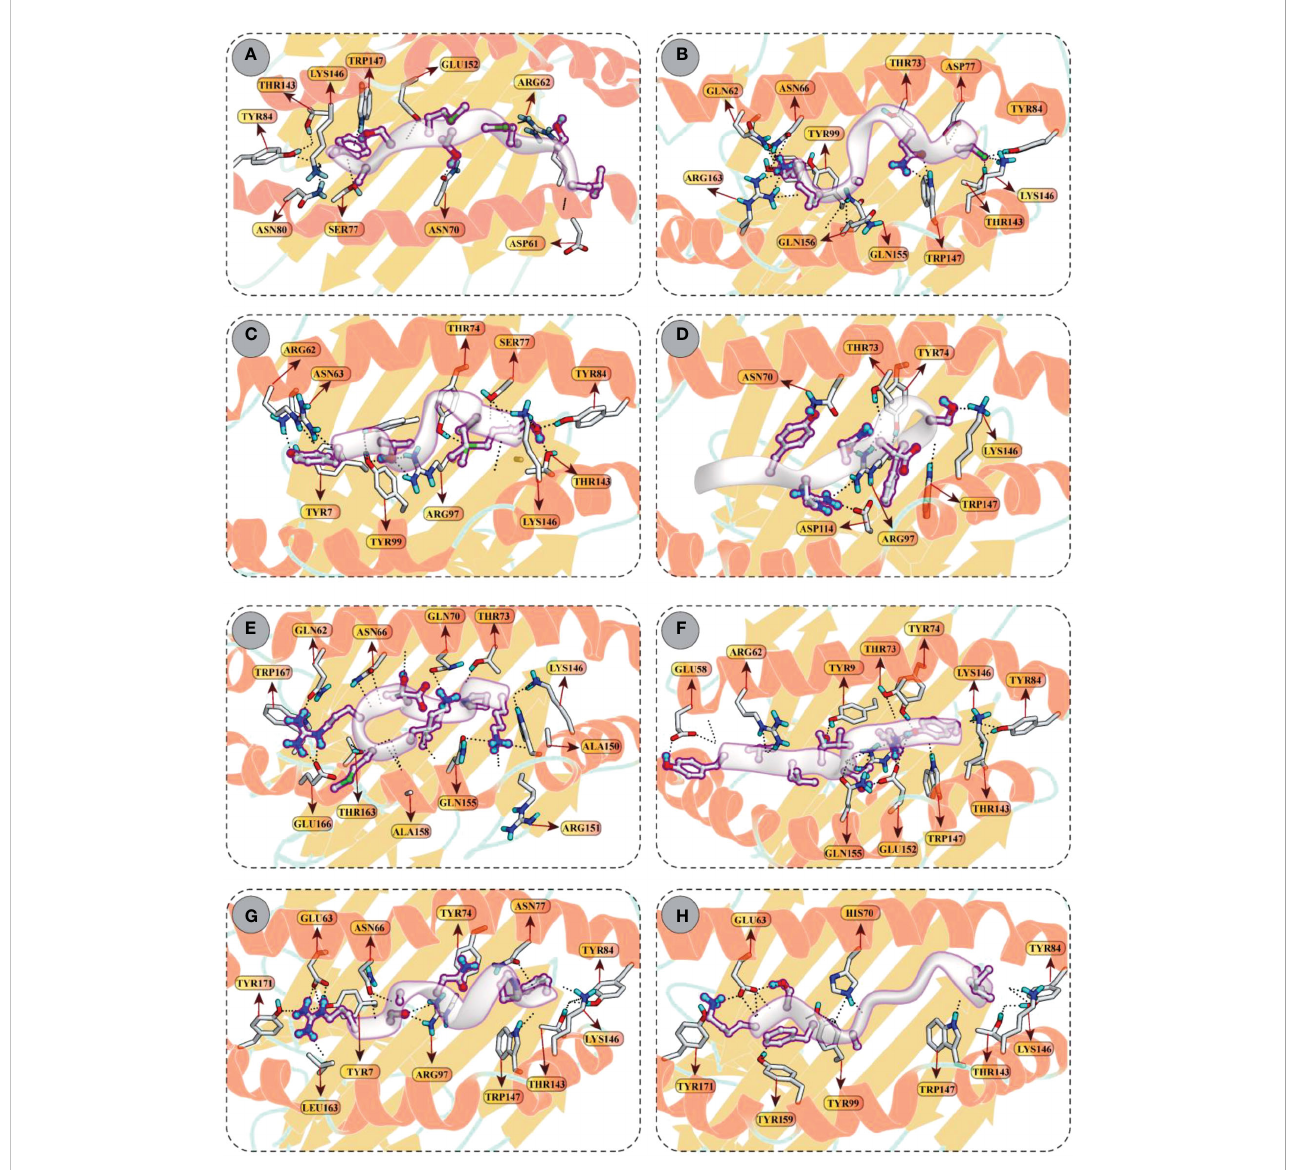
FIGURE 5 Molecular docking of CTL peptides (grey) and HLA class I molecules (A) Peptide LSMITMSAF attached with the binding groove of the HLA-B*15:01 (B) Peptide CINNTIALK attached with the binding groove of the HLA-A*11:01 (C) Peptide MSIMPVLTY attached with the binding groove of the HLA – B*35:01 (D) Peptide IAYRNDTSF attached with the binding groove of the HLA – B*35:01 (E) Peptide KMRDTLPAK attached with the binding groove of the HLA – A*30:01 (F) Peptide YVLSTIHIYV attached with the binding groove of the HLA-B*15:02 (G) Peptide RSANMSAPF attached with the binding groove of the HLA-B*58:01 (H) Peptide KTFAIIAIV attached with the binding groove of the HLA-A*02:06. All H-bonds are represented in dotted lines and the interacting residues of HLA class I receptor is shown in